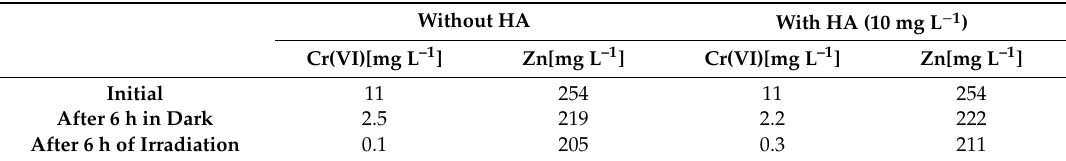
Table 2. Concentrations of zinc in samples from the experiments with the diluted galvanizing e ffl uent with and without humic